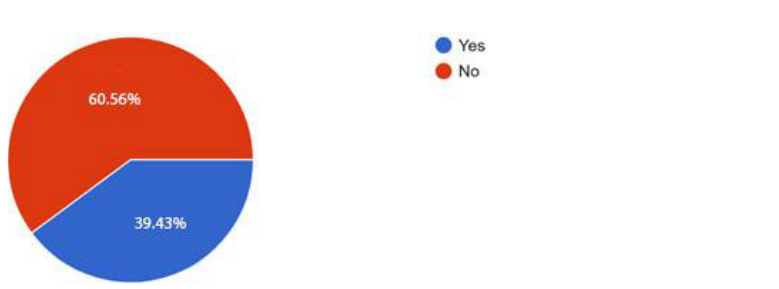
Figure 10. Obtained statistical data for the first question in the initial survey. Table 2. Age distribution of the users.